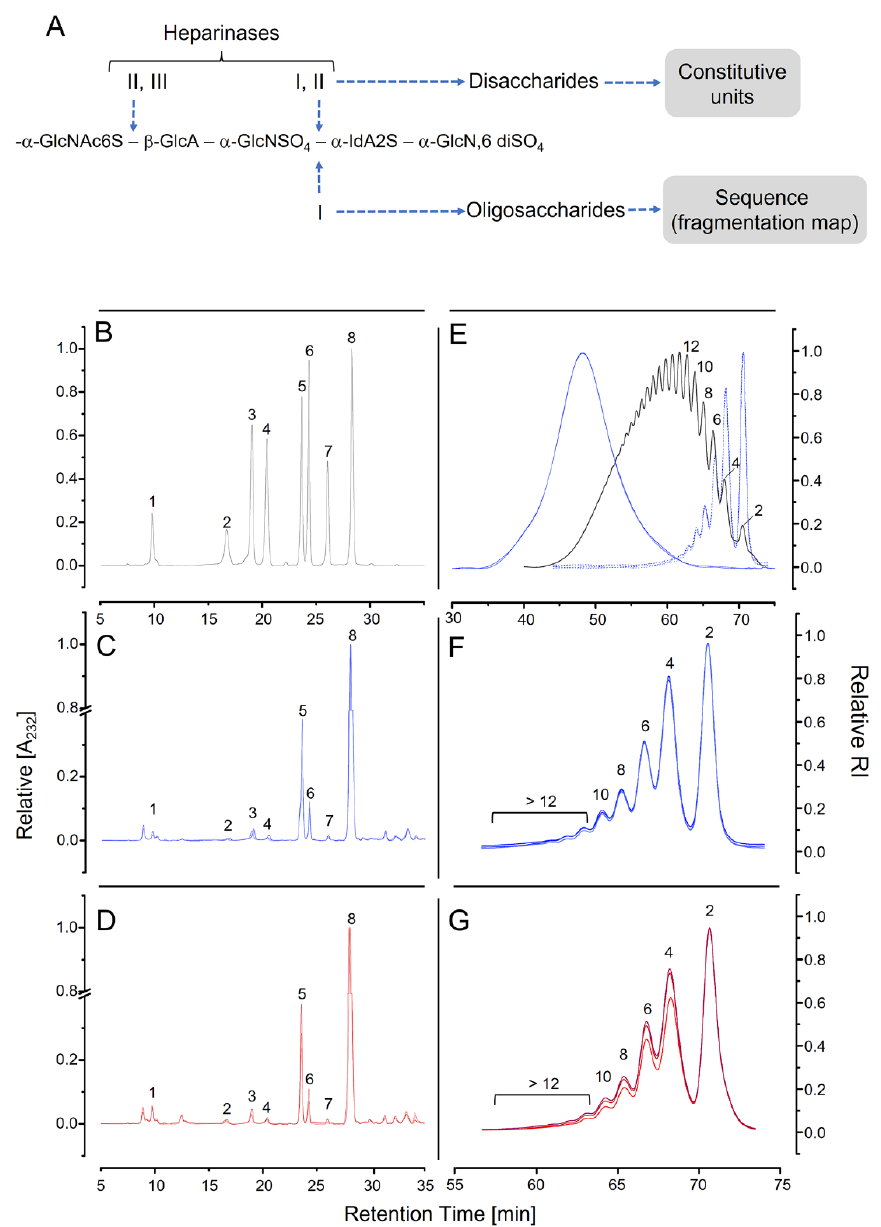
Figure 6. Analyses of pharmaceutical heparins by digestions with heparinases. Panel ( A ): Summary of the experimental approach employed in the analyses. Panels ( B – D ): Chromatograms of the disaccharides formed by the digestion of heparins with a mixture of heparinases I, II, and III. Elution of standard disaccharides is on Panel ( B ) ( black ) and enumerated as in Table 4. Panels ( C , D ) show overlapping of the elution profiles of the disaccharides formed from 3 heparin batches from each manufacturer 1 ( blue ) and manufacturer 2 ( red ) by digestion with the heparinases. Panels ( E – G ): Size-exclusion chromatograms of the oligosaccharides formed after the digestion of heparins with heparinase I. Panel ( E ) shows the chromatograms of non-digested heparins ( dashed line in blue ), three batches from manufacturer 1, and the oligosaccharides formed by the action of the enzyme (in blue). The black-dotted line shows the elution of the “International standard of low-molecular-weight heparin for molecular weight calibration”. Numbers in the panel indicate the degree of polymerization of the oligosaccharides. Panels ( F , G ) show an expansion of the chromatograms (fractions 55 → 76) of the products formed after the digestion of heparins from the two manufacturers by heparinase I.